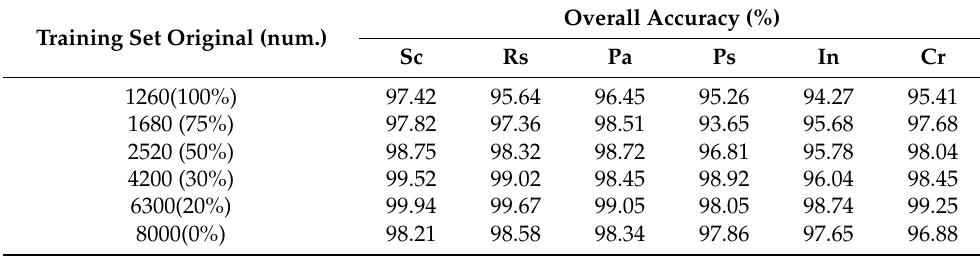
Table 2. Classification results from various numbers of samples. Training Set Original